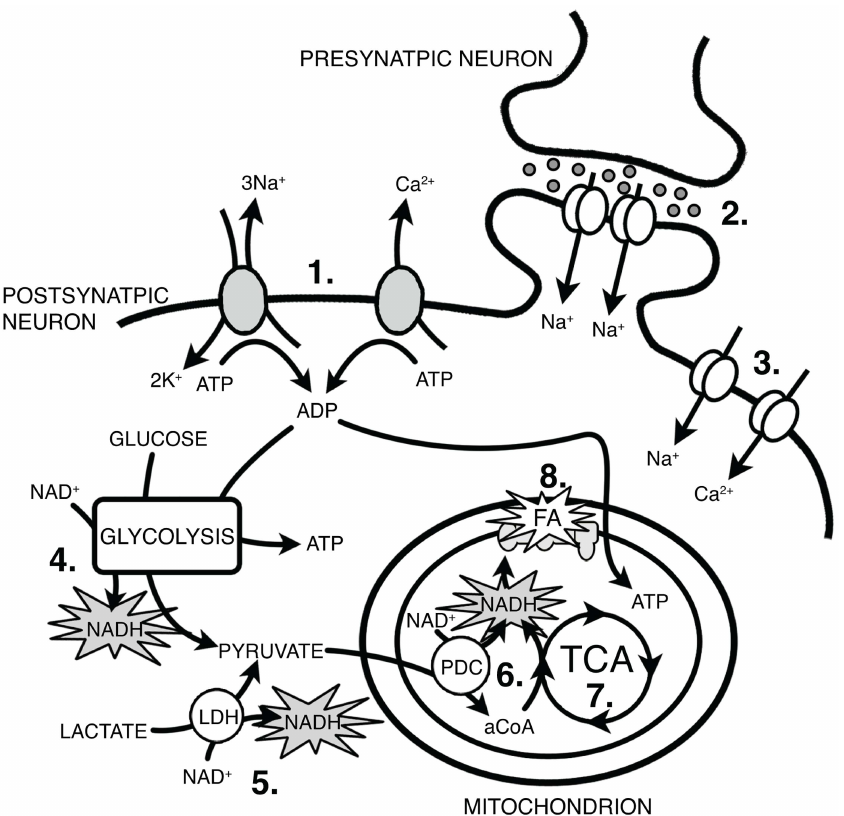
Fig 1. Principles of intrinisic flavoprotein and NAD(P)H fluorescent imaging. Instrinsic flavoprotein(FA) and NAD(P)Hfluorescentsignals are attributed to mitochondrial activity. Changesin fluorescence are correlatedwith neuronalactivity through increasesin metabolicdemand resulting from ionic pumps and synapticactivity. (1) Na + /K + and Ca 2+ ATPases, (2) synaptic NMDA and AMPA receptors, (3) voltage-gated Na + and Ca 2+ channels,(4) glycolysis, (5) lactate dehydrogenase (LDH), (6) pyruvate dehydrogenase complex (PDC), acetyl-coenzyme A (aCoA), (7) tricarboxylic acid cycle (TCA), (8) electrontransport